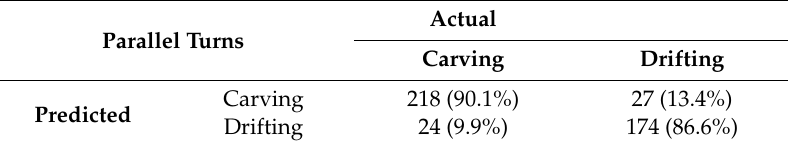
Table 6. Confusion matrix for parallel turns—Decision